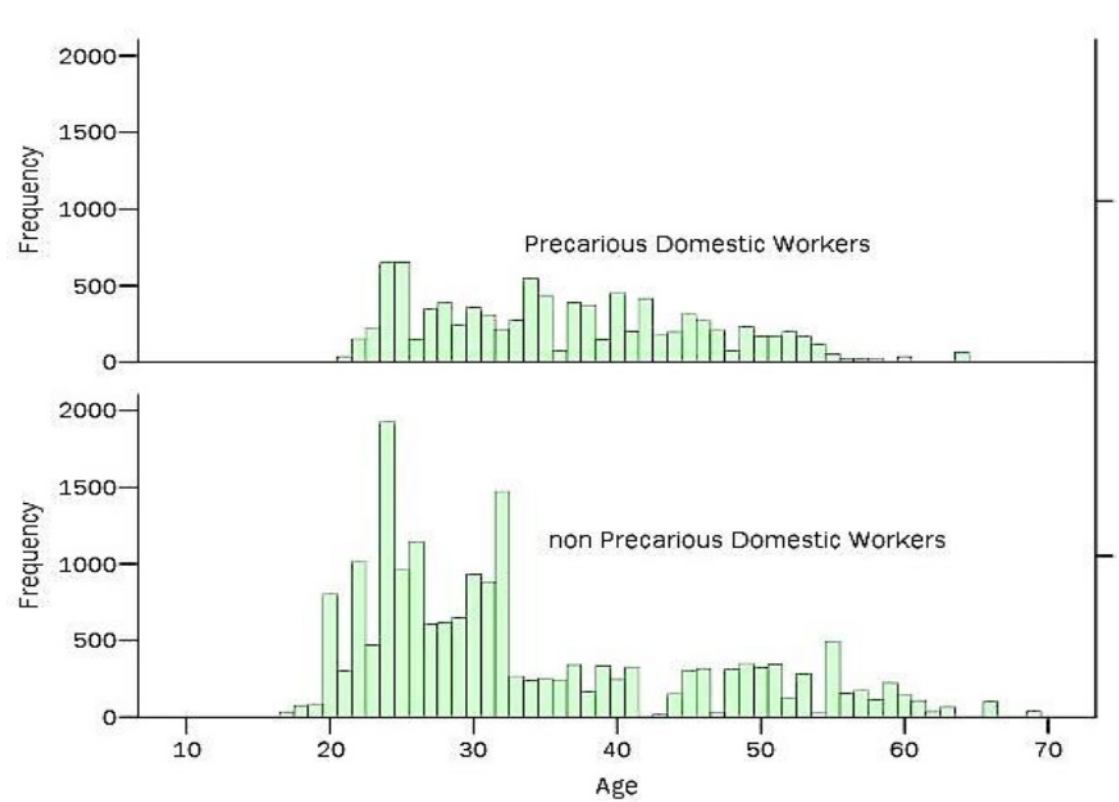
Figure 5. Distribution of precarious domestic workers by age (2019). Data source: Eurostat EU-SILC (2020).